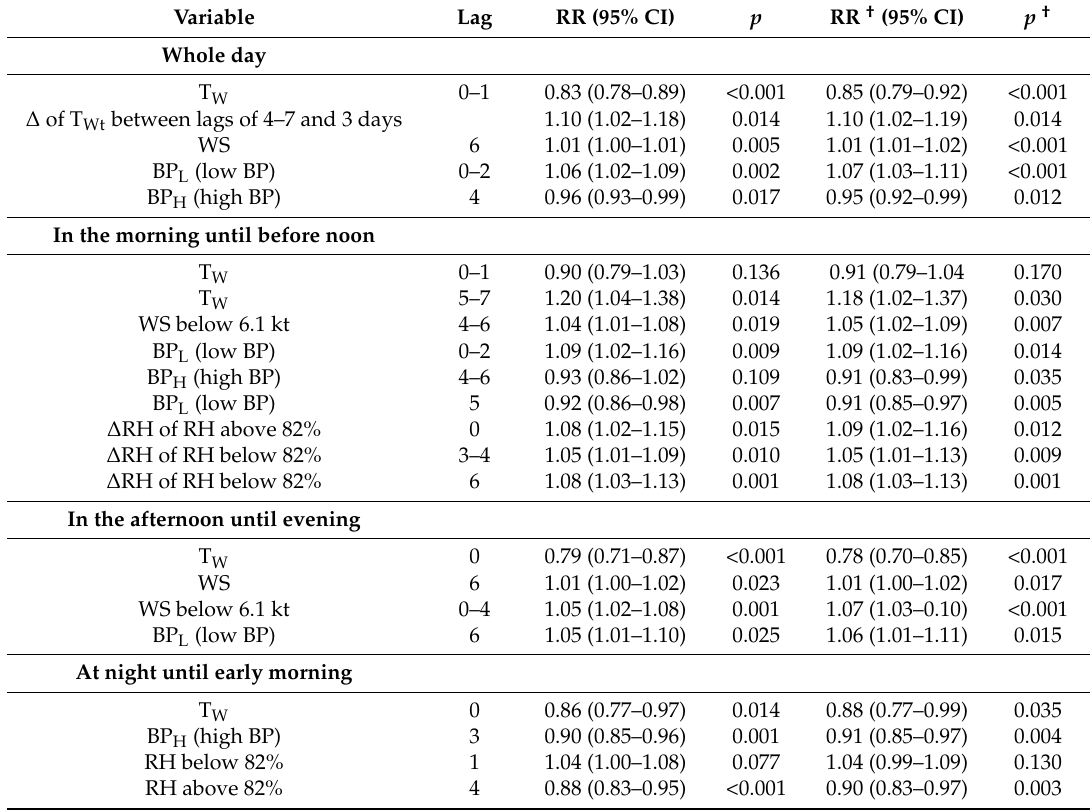
Table 3. Multivariate associations between weather variables and emergency calls for elevated arterial blood pressure, in rate ratio (RR) per increase of standard unit *; adjusting for day length, month, years, and the day of the